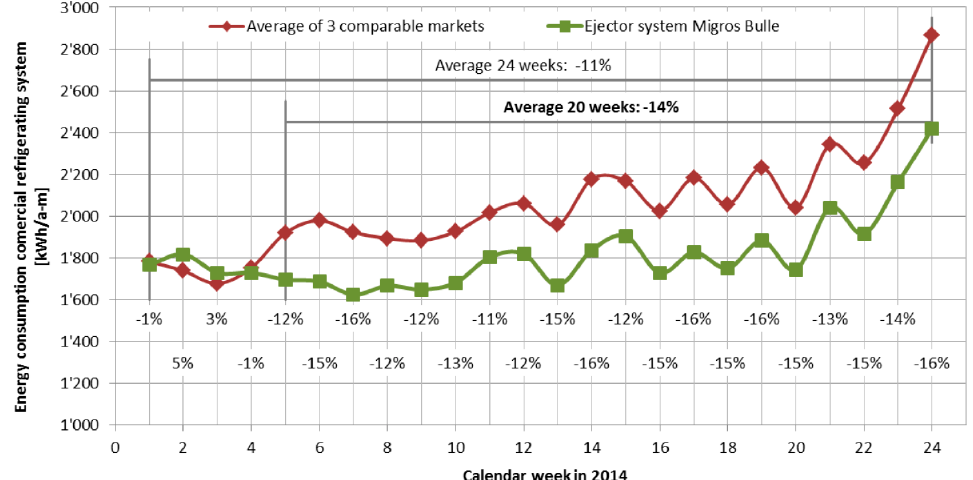
Figure 20. Energy consumption comparison between the first unit implementing the multi-ejector concept and three similar systems relying on parallel compression in the Swiss climate context [42].